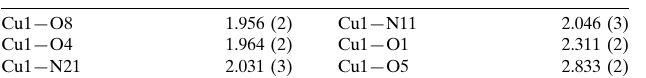
Selected bond lengths (A˚ ).